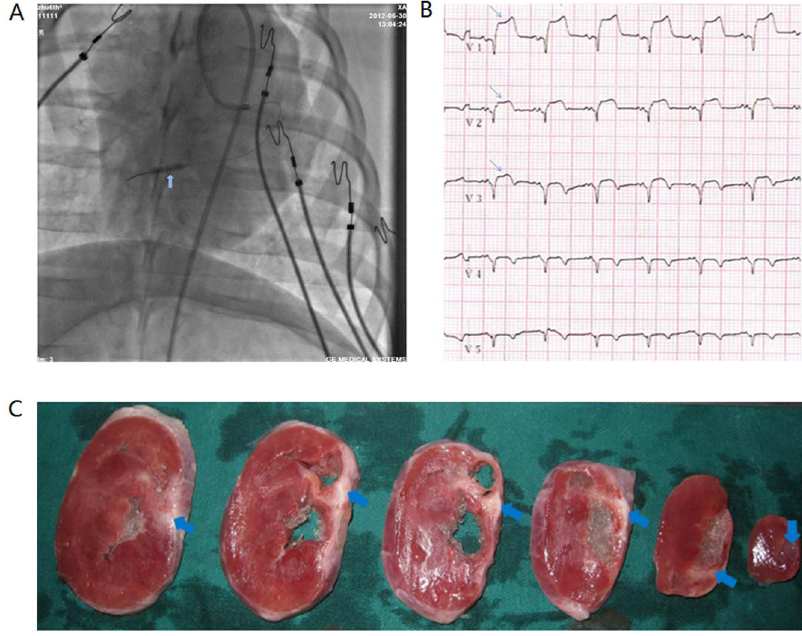
Figure 1. Model establishment and verification. (A) Balloon occlusion was performed to induce MI. (B) A substantial elevation of the ST segment was detected based on ECG. (C) TTC-positive staining demonstrated successful model establishment.